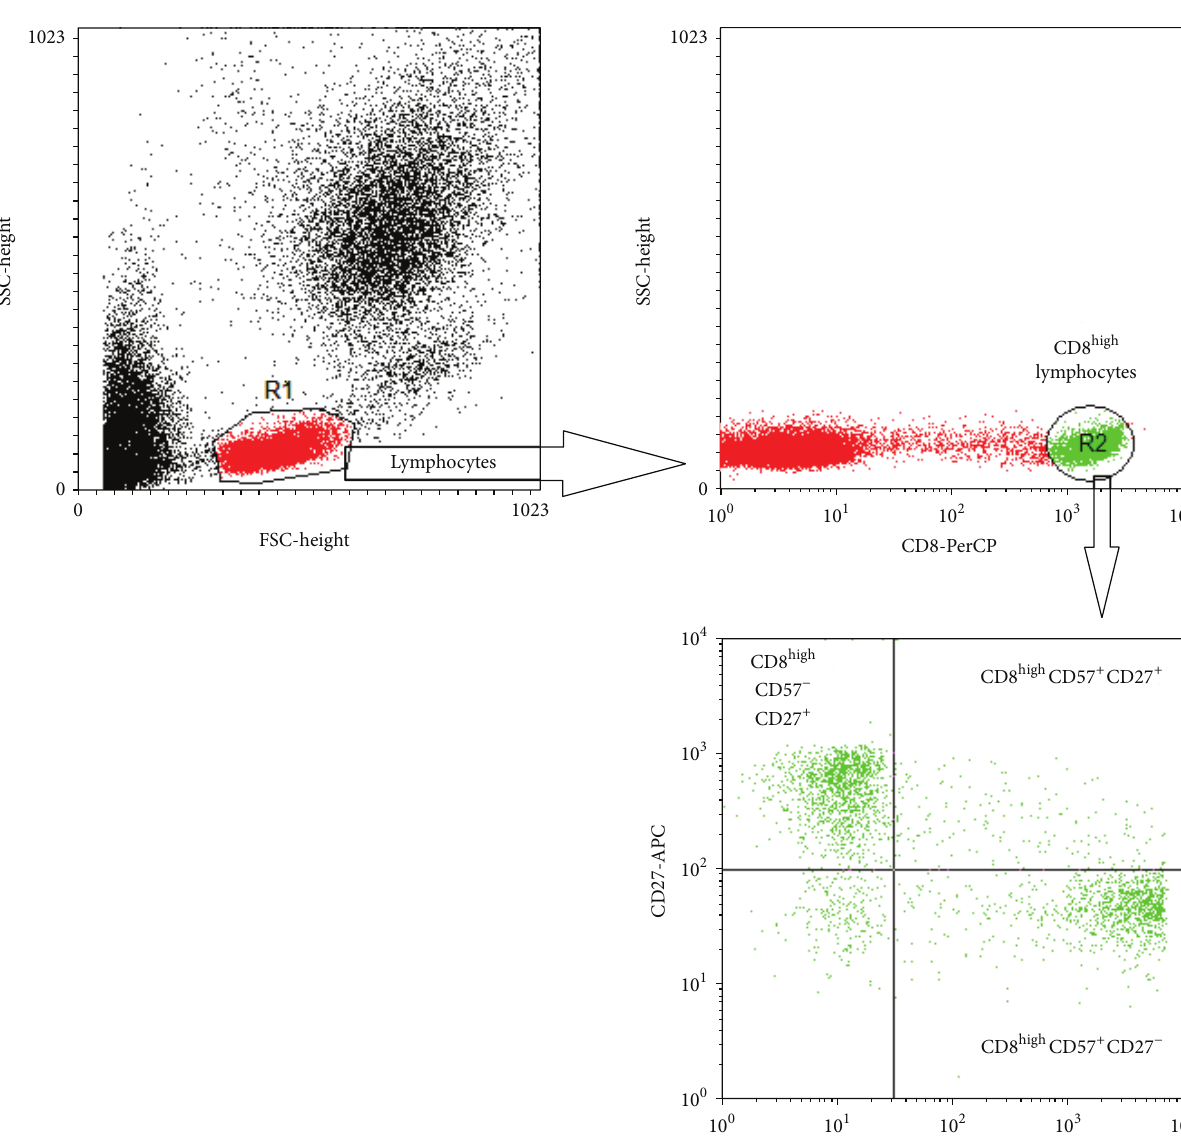
Figure 1: Representative dot plots. CD 8 high lymphocytes in the CD8 + subset were determined in the flow cytometric SSC/CD8-PerCP dot plot and percentages of CD 8 high CD57 − CD27 + lymphocytes were determined in gated CD 8 high subset in the flow cytometric CD57-FITC/CD27- APC dot